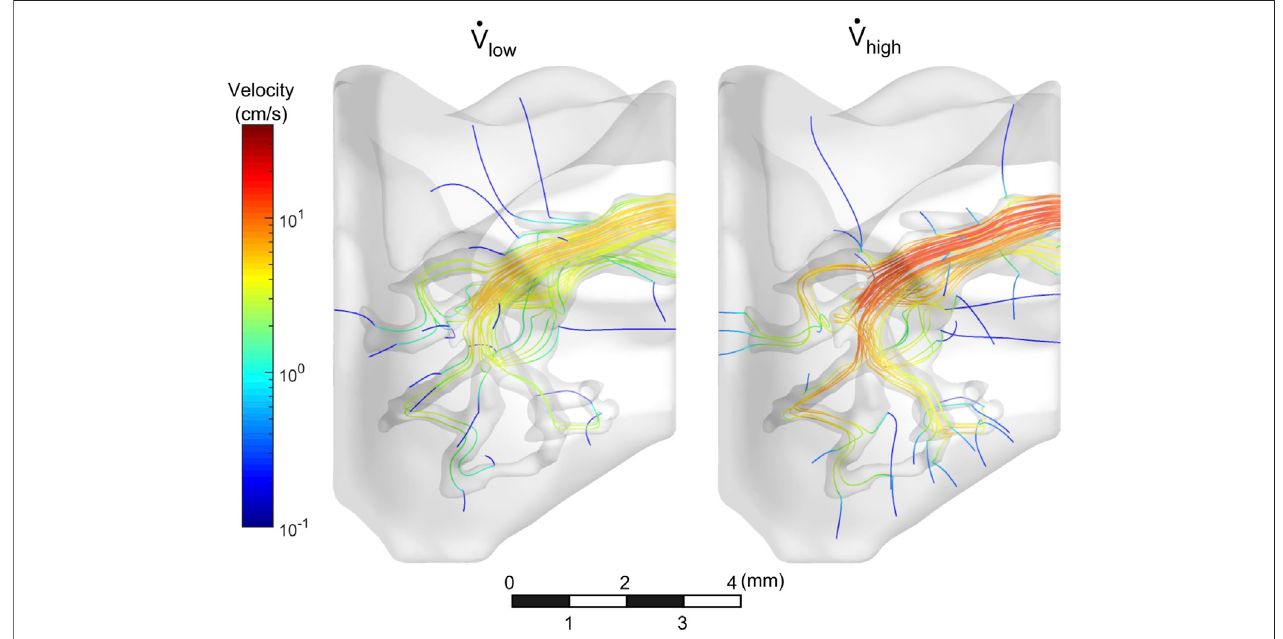
FIGURE 4 | Velocity streamlines throughout vasculature. Streamlines circulated out the PV, while some permeated through vessel walls.